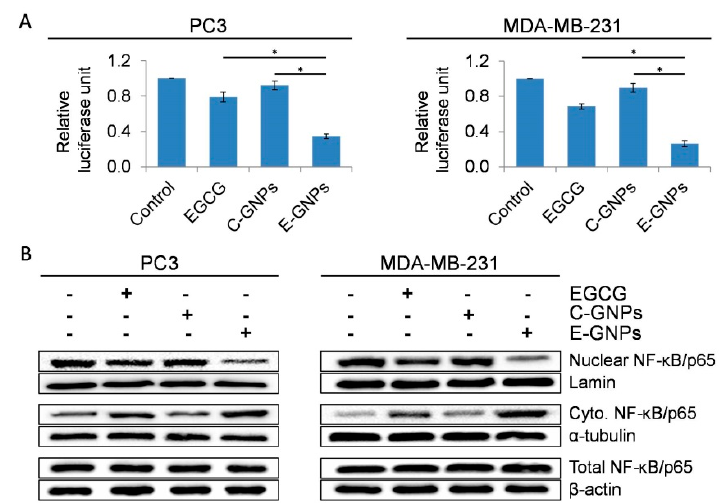
Figure 7. E-GNPs abrogate nuclear translocation and transcriptional activity of NF- κ B in cancer cells. ( A ) The NF- κ B-luciferase reporter construct and Renilla luciferase control reporter vector transfected PC3 and MDA-MB-231 were treated with EGCG (11.9 µ M), C-GNP (50 µ g/mL), or E-GNP (50 µ g/mL) and NF- κ B transcriptional activity was examined after 24 h using the Dual Luciferase Assay System. ( B ) After treatment with EGCG, C-GNPs, and E-GNPs, total protein was isolated and immunoblot analysis was performed to analyze the expression of nuclear NF- κ B, cytosolic NF- κ B, and total NF- κ B. Lamin, α -tubulin, and β -actin were used as loading controls respectively. Bars represent the mean of triplicates ± SD, * p < 0.05.